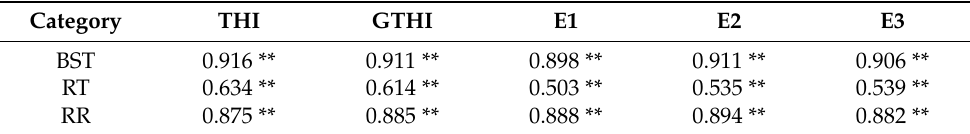
Table 10. Correlation analysis of physiological indices and physiological indicators of buffaloes. Category BTCI IHTI P1 P2 P3 BST 0.861 ** RT 0.528 ** − 1.000 ** 0.609 ** 0.615 **